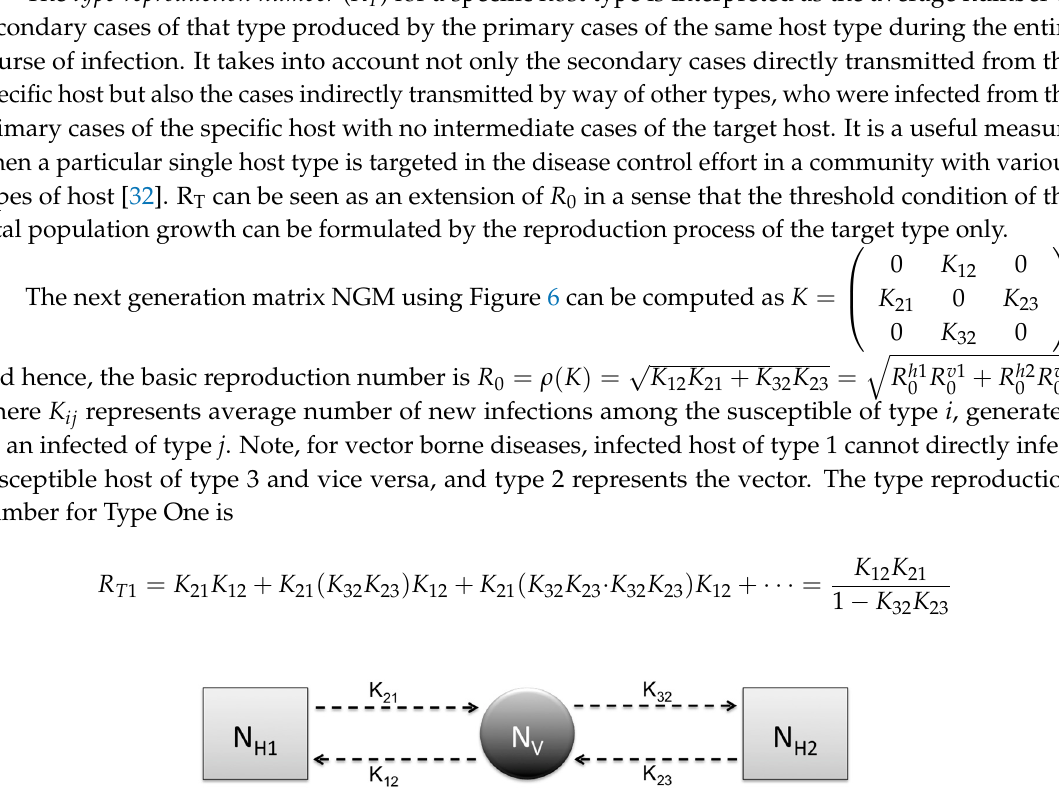
Figure 6 . Flow chart of general vector borne model with two types of hosts H1 and H2 as well as one vector population.